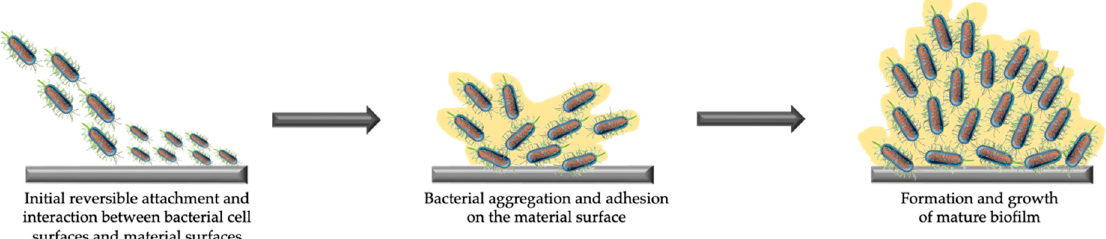
Figure 4. Illustration of the biofilm-associated infections process on the medical device.